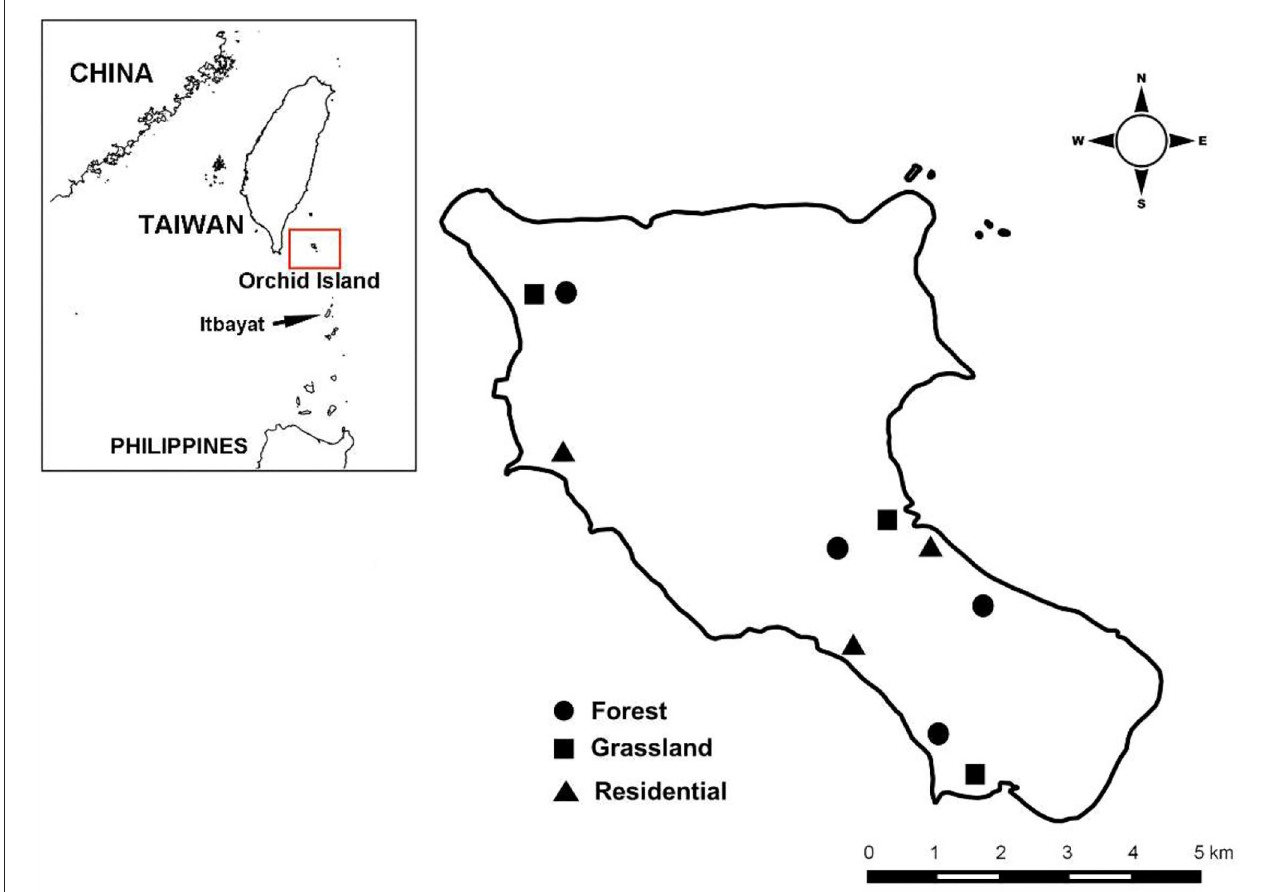
FIGURE 2 | Study sites on Orchid Island of